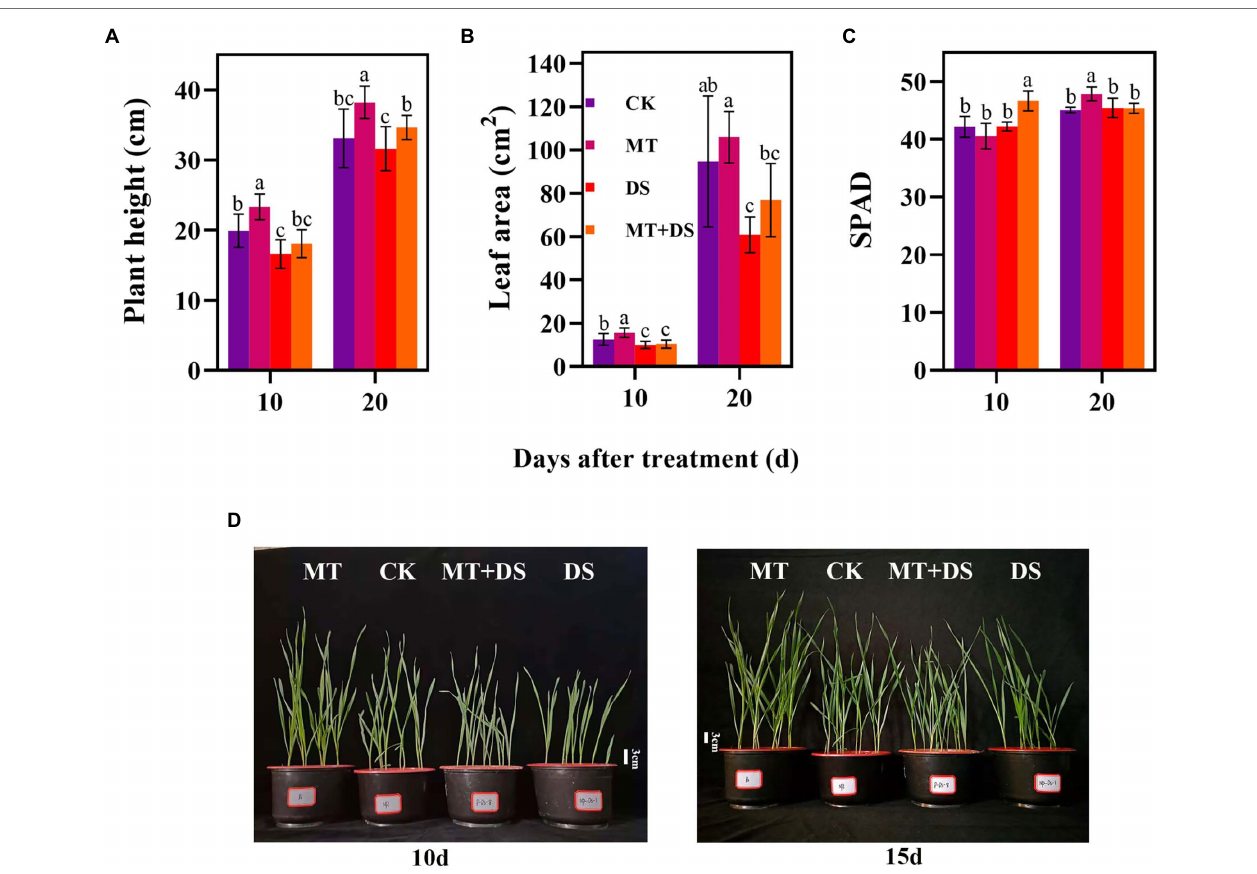
FIGURE 5 | MT at 20 μ M concentration was used as the optimal concentration for priming triticale seeds, unprimed +70–75% relative water content as CK, primed +70–75% relative water content as MT, unprimed +40–45% relative water content as DS, and primed +40–45% relative water content as MT+DS. (A) Plant height (PHT), (B) leaf area (LEA), (C) SPAD (relative chlorophyll content) values on the 10 th and 20 th d after cultivation, and (D) phenotypic traits of triticale seedling in pot cultivation for 10 th and 15 th . Depicted are the means of 10 replicates ± standard error. For each trait, bars with the same letter are not significantly different ( p < 0.05). Different lower letters indicate significant differences among the treatments ( p <